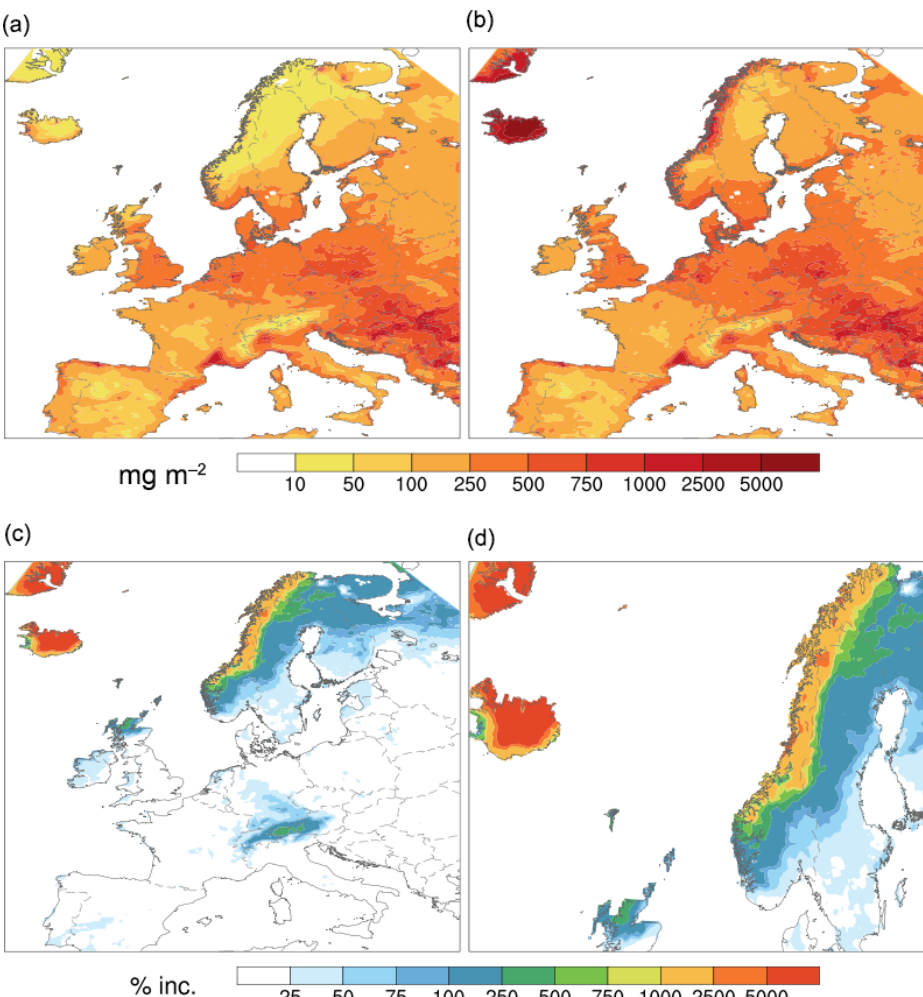
Figure 8. (a) Simulated total deposition of SO x (wet and dry) over Europe from September to November 2014 for no_hol and (b) bas_hol simulations; (c) percent increase in SO x deposition due to the Holuhraun emissions; (d) shows the same as (c) but zoomed into Norway and northern